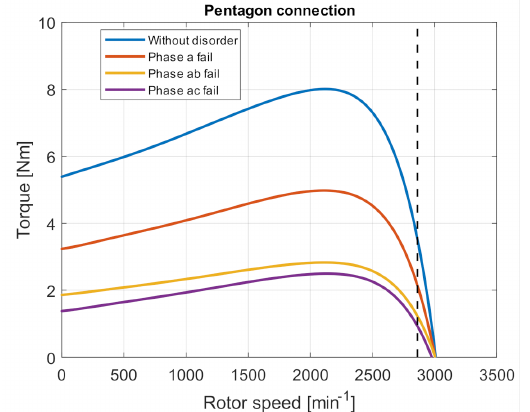
Figure 5. Torque characteristics in fault-free state and fault states in pentagon connection, U IN = 5 × 230 V, 50